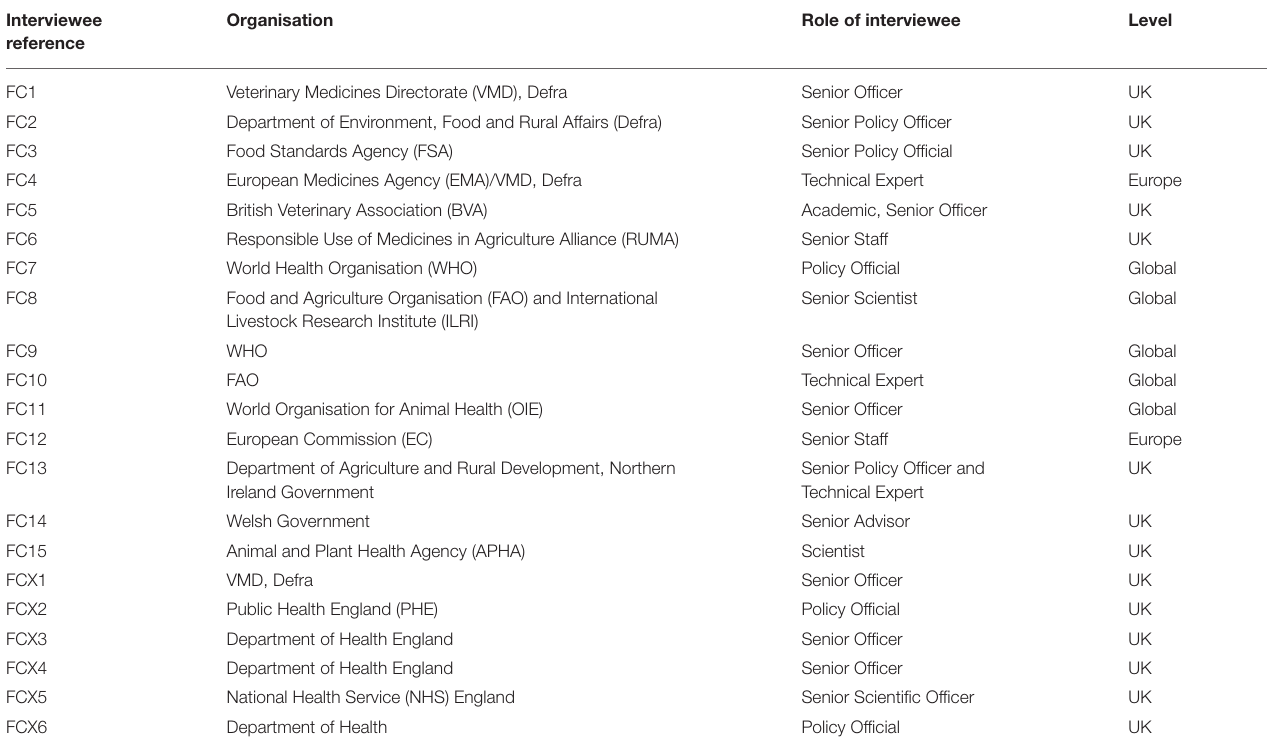
TABLE 1 | Informant descriptions for all people